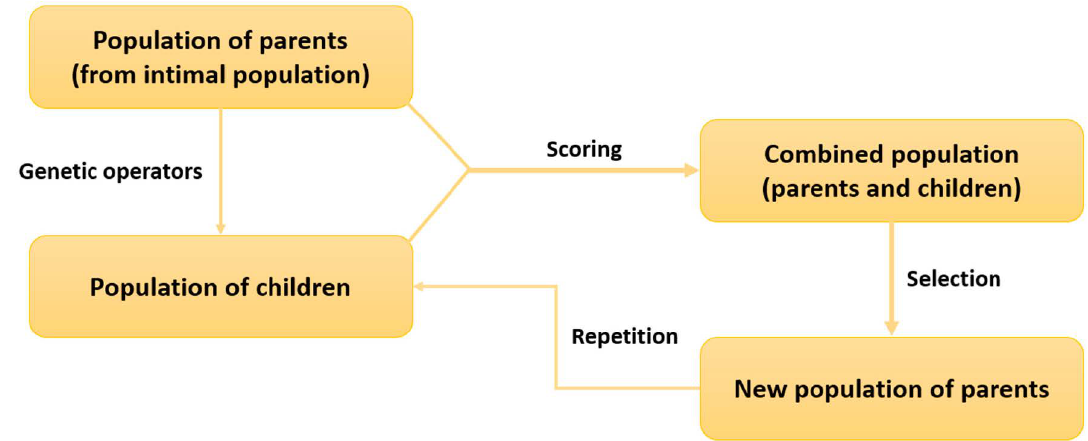
Figure 2. Schematic representation of the evolutionary algorithmic cycle in de novo drug